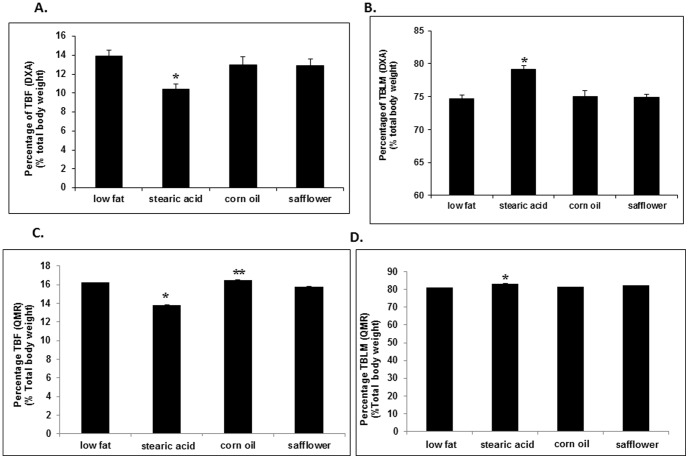
Body composition measured by DXA and QMR at week 18.Total body fat (TBF) and total body lean mass (TBLM) were assessed by DXA (A, B) and QMR (C, D), n = 10 per diet group. Mice on the stearic acid diet had a 25% decrease in TBF by DXA and 15% by QMR as compared to the low fat diet fed mice (*, p<0.009) and a 12% decrease as compared to mice on the corn oil diet by QMR **, p<0.008). Mice on the stearic acid diet also had a 4% increase in TBLM measured by DXA when compared to when compared to the other diet groups (*, p<0.01) and to the low fat diet fed mice when measured by QMR (*, p = 0.047).